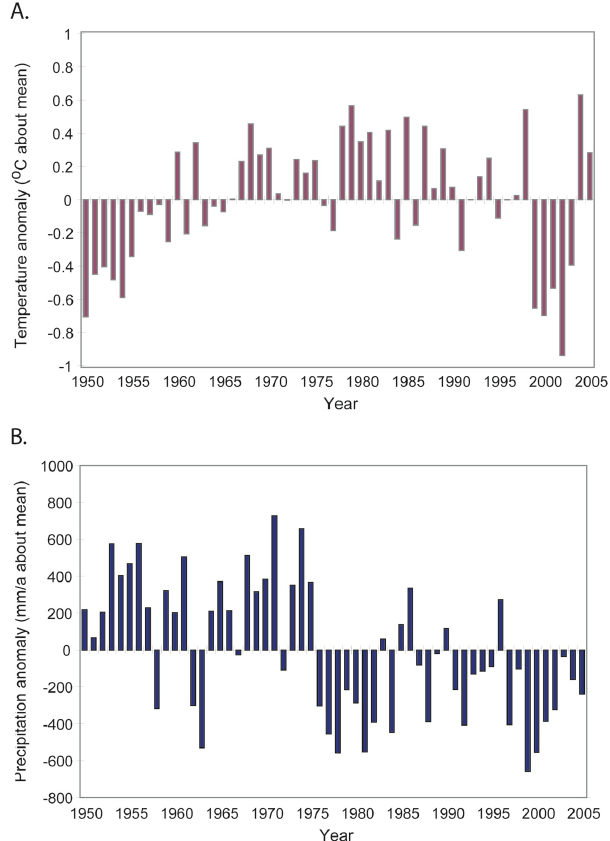
Fig. 6. Reconstructed annual temperature (a) and precipitation (b) anomalies at Laguna San Rafael for the period 1950 to 2005. Local values were calculated using NCEP-NCAR data and the relation- ships established in Eqs. (1) and (2). Anomalies shown are differ- ences from the mean value for the period: mean annual temperature was 8.9 ◦ C; mean annual precipitation at LSR was 3.60mw.eq.